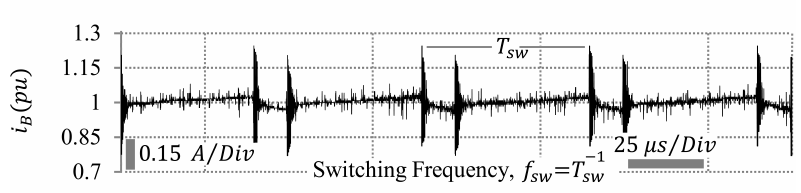
Figure 6. Ripple of the battery current i B